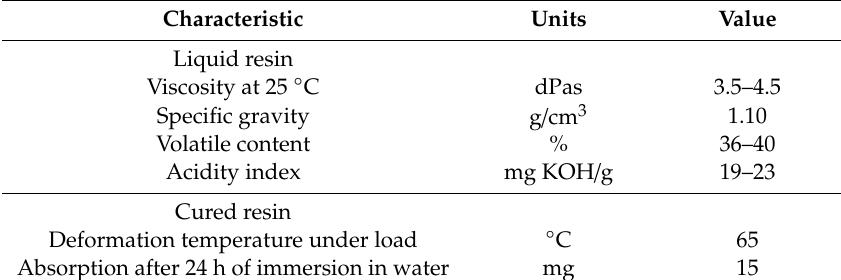
Table 1. Polyester CRYSTIC 406 NT liquid and cured resin